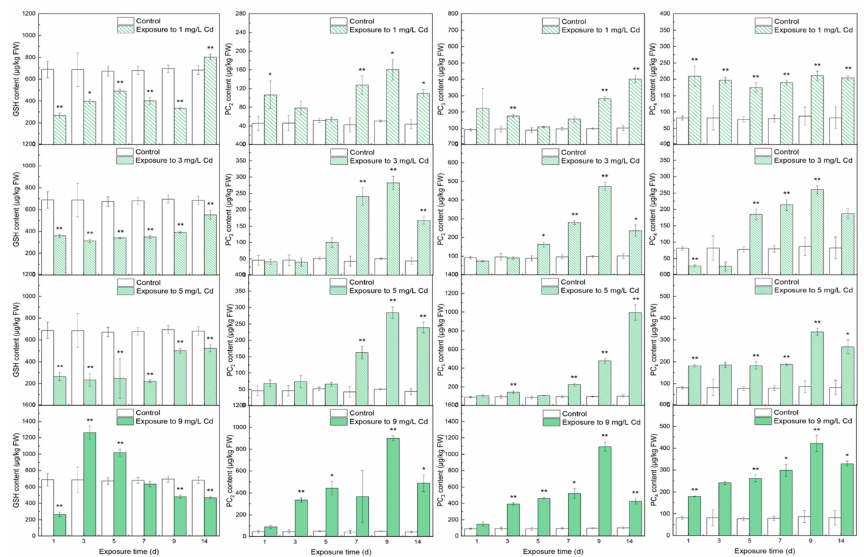
Figure 3. The contents of thiols in shoots under different levels of Cd stress. All values represent the means ± SD of three replicates. Stars indicate significant differences to the control (**: p < 0.01, *: p < 0.05).